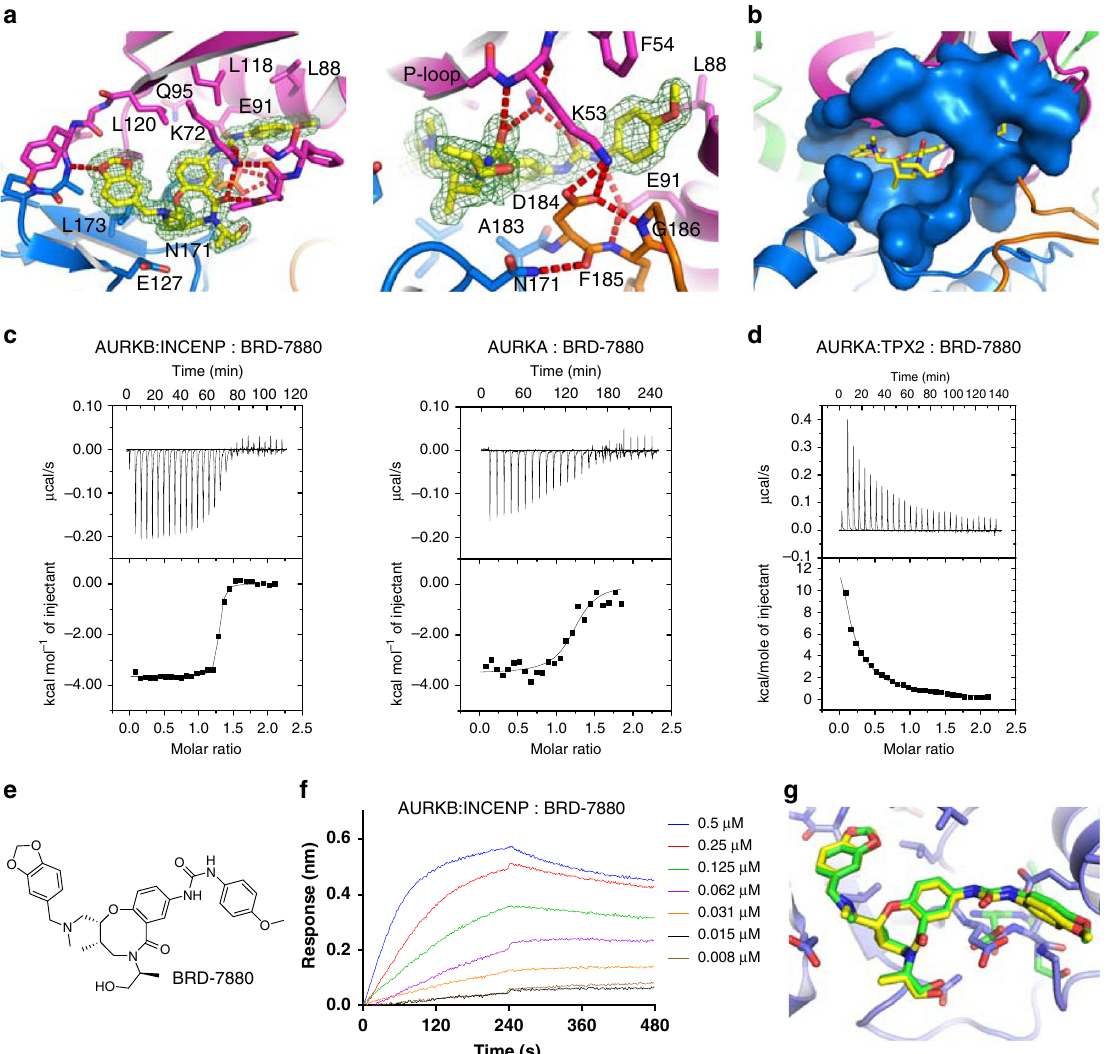
Fig. 5 BRD-7880 binding to AURKC:INCENP. a BRD-7880 forms a single hydrogen bond to the kinase hinge region from its benzo − 1,3-dioxole moiety, and multiple hydrogen bonds to the P-loop (Lys53) and to Lys72 and Glu91. A 2 F o - F c electron density map is shown in green around BRD-7880, contoured at 1.0 σ (0.4 eÅ -3 ) b The central 8-membered ring of BRD-7880 allows excellent shape complementarity to the ATP-binding site of AURKC. c Isothermal titration calorimetry con fi rmed BRD-7880 has signi fi cantly higher af fi nity for AURKB:INCENP over AURKA, due to more favourable entropy of binding (Supplementary Table 2). d Selectivity of BRD-7880 for AURKB:INCENP over AURKA:TPX2 is increased due to a non-ideal interaction, most likely the forced, possibly partial, dissociation of TPX2 from AURKA upon BRD-7880 binding. e Chemical structure of BRD-7880. f BRD-7880 has slow binding kinetics with AURKB:INCENP, with the long half-life of dissociation contributing to its potent binding. g BRD-7880 binds to AURKC:INCENP and AURKA in the same conformation, with the active site residues of AURKA adopting the same conformations as those of AURKC, with the exception of the DFG motif (residues 274 to 276 of AURKA). AURKC is shown in blue with bound BRD-7880 in yellow, and AURKA is shown in green